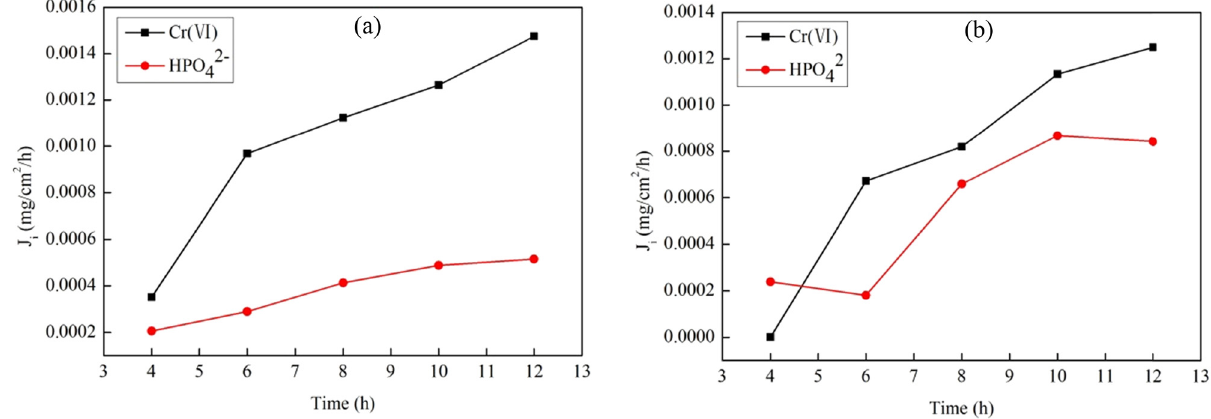
Figure 8: Permeation fl ux changes of Cr ( VI ) and HPO 42− on IICM ( a ) ; permeation fl ux changes of Cr ( VI ) and HPO 42− on NICM ( b ) .